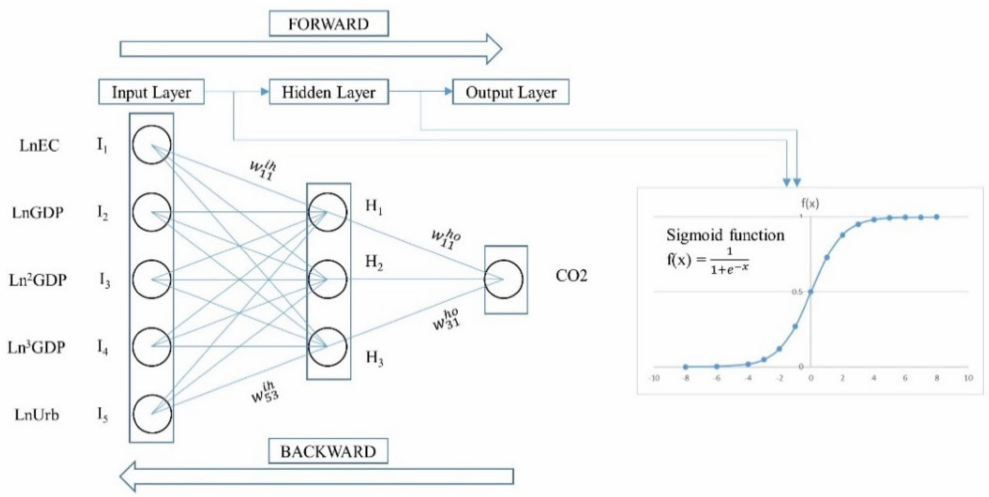
Figure 2. Illustration for the BPN procedure with three hidden